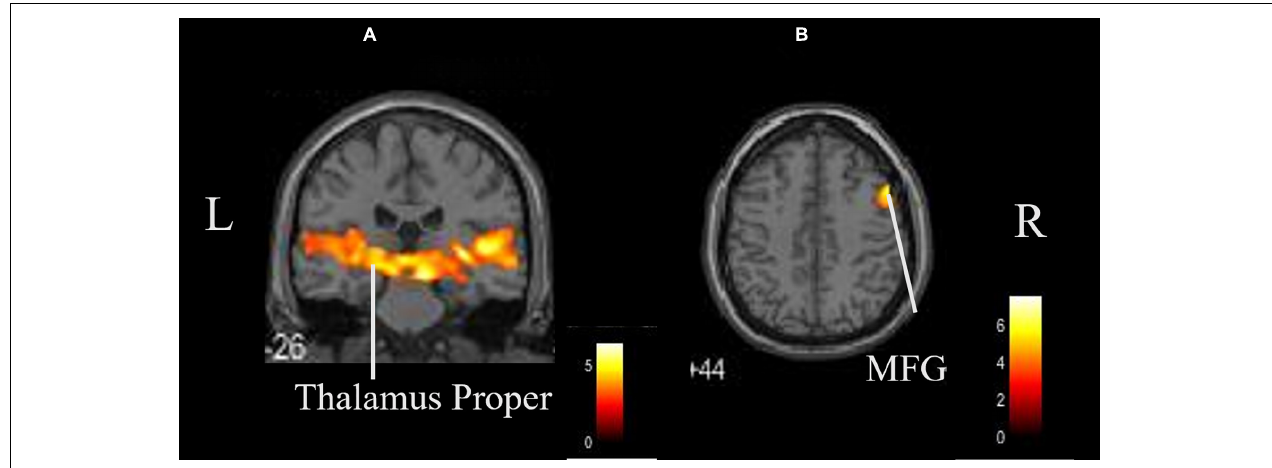
FIGURE 2 | Whole brain activation while listening to classical music compared with the resting state. Significant activation was observed in the right middle frontal gyrus and left thalamus proper. (A) Coronal view. (B) Axial view. L, left; R, right. MFG, middle frontal gyrus.